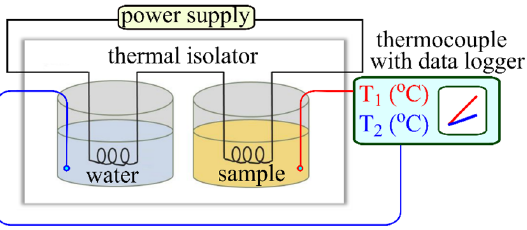
Figure 1. Schematic view of the experimental setup for heat capacity measurements of